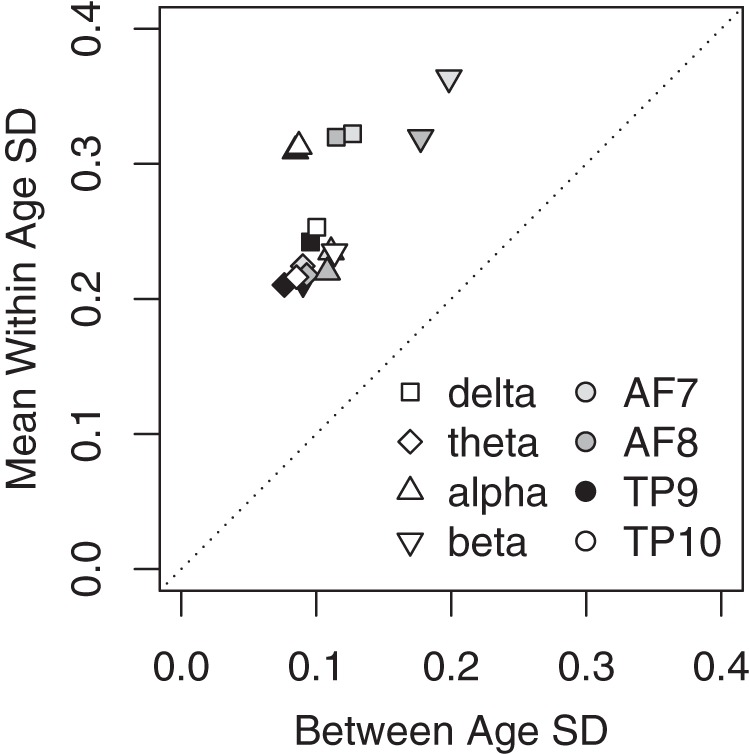
Standard deviation of the average band power across ages (x-axis) plotted with the average standard deviation of each band power across participants within each age (y-axis). Within-age SD was calculated by calculating the SD across participants at each given age. Ages 78+ all had two or fewer participants, so we grouped them into a single age bin. Mean within-age SD (y-axis) was calculated as the average within-age SD. Between-age SD (x-axis) was calculated by first computing the mean band power for each individual age, then calculating the SD across these values.